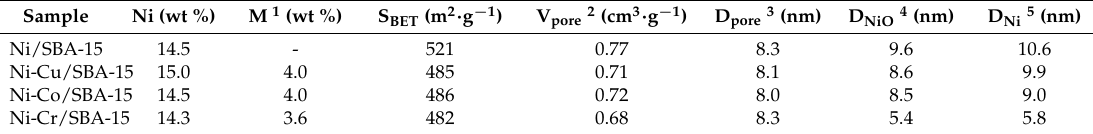
Table 1. Physico-chemical properties of the Ni-(Cu,Co,Cr)/SBA-15